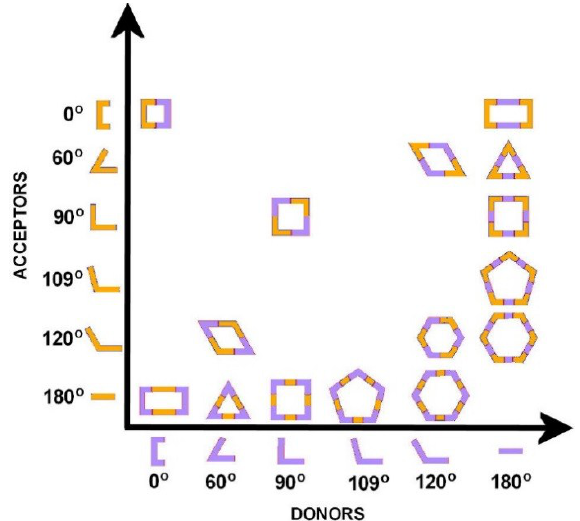
Figure 19. Formation of 2D architectures constructed by self-assembly of ditopic building blocks. Adapted from Chem. Rev. 2011 , 111 , 6810–6918. Copyright (2011) Royal Society of Chemistry.